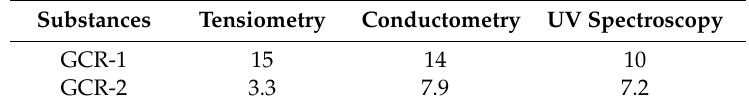
Table 1. Comparison of CAC values (mM) obtained by different methods for GCR-1 and GCR-2.